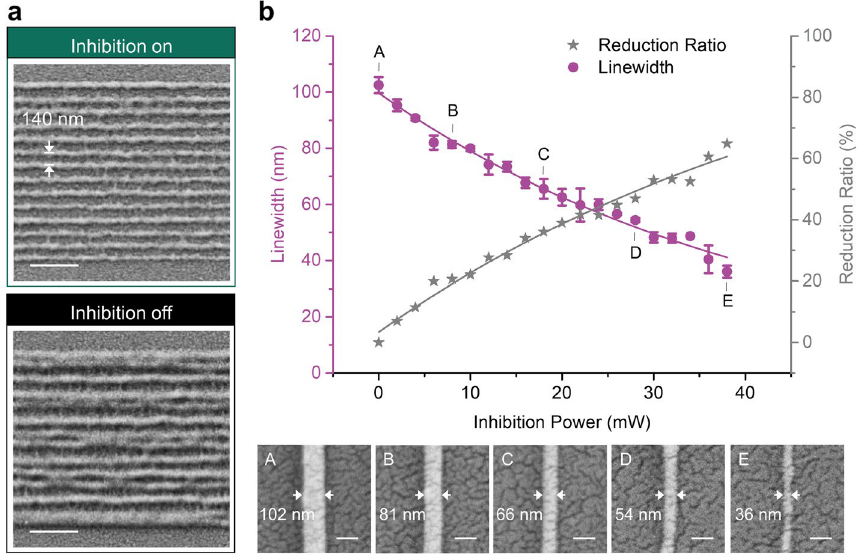
Fig. 3 Resolution enhancement and feature size reduction by SC-PPI. a Grating structures with a pitch of P 140 nm are fabricated to demonstrate the lateral resolution enhancement by SC-PPI. Scale bar: 500 nm. = b Polymer linewidth versus the power of the CW inhibition laser beam with a fixed scanning velocity of 1 mm s − 1 . The reduction ratio is defined as ( L TPL L PPI )/ L TPL , where L TPL and L PPI were the linewidths of TPL and − SC-PPI. The insets illustrate the top-view SEM image of the data points A–E. Scale bar: 100